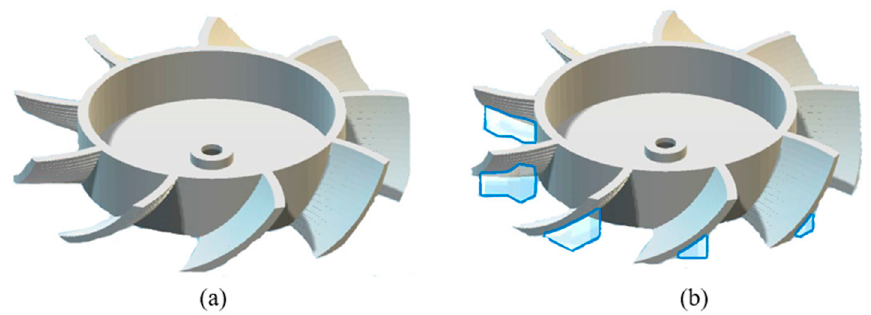
Figure 1. ( a ) An engineering part; ( b ) Part needs supports for printability.